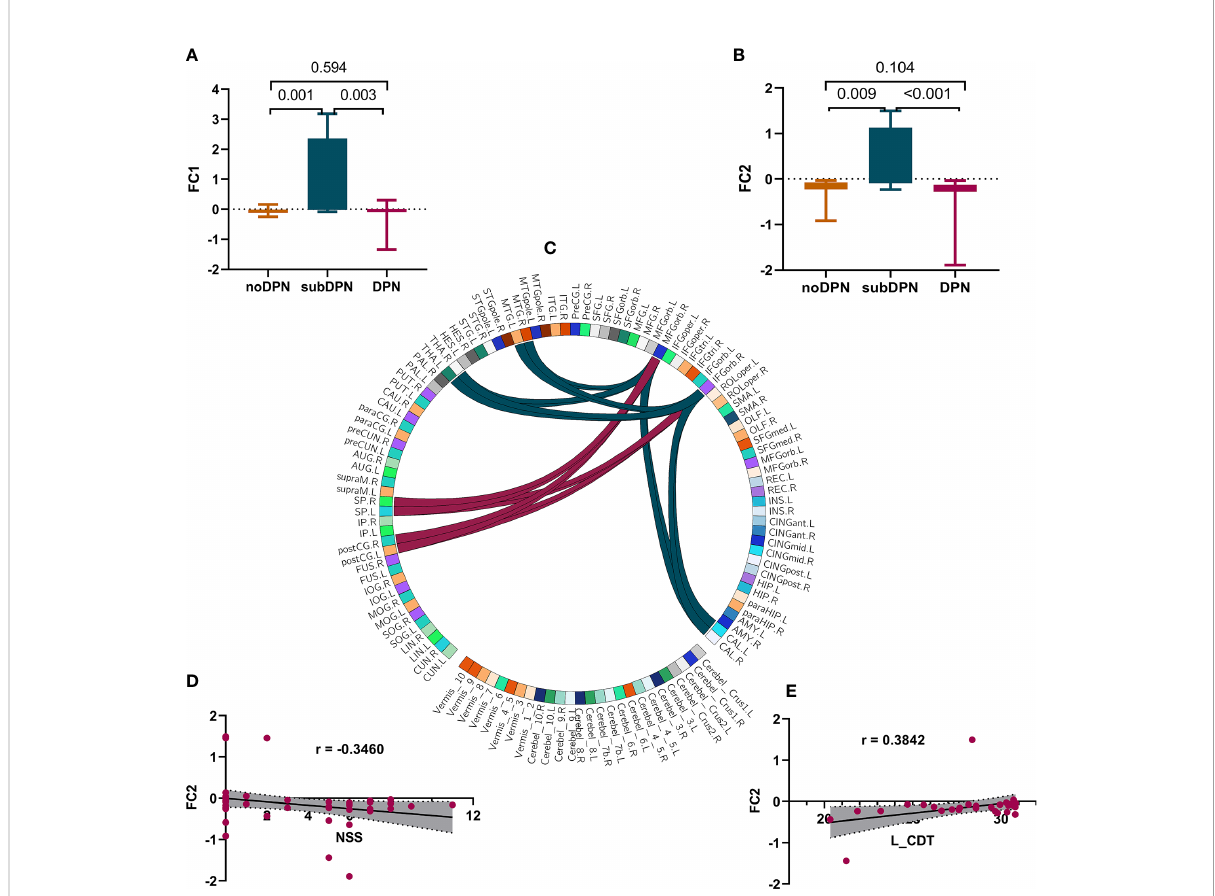
FIGURE 3 Presentations offunctional connectivity differences among groups and related correlations. (A, B) . post-hoc results of FC1 (A) and FC2 (B) . (C) a sketch diagram denoted a signi fi cant difference in functional connectivity between cerebral regions. The dark green and red link lines denote FC1 and FC2, respectively. (D, E) . correlations of FC2 with NSS (D) and left CDT (E) . FC, functional connectivity values after fi sher-Z transformation; FC1. connectivity of OFC with bilateral MTG/THA/CAL. FC2. connectivity of OFC with bilateral postCG/SP. L, left; R, right. OFC, the orbitofrontal cortex; MTG, middle temporal gyrus; THA, thalamus; CAL, calcarine gyrus; postCG, the postcentral gyrus; SP, superior parietal gyrus; NSS, the Neuropathy Symptom Score; CDT, cold detection threshold; DPN, type 2 diabetic polyneuropathy; subDPN, subclinical type 2 diabetic polyneuropathy; noDPN, type 2 diabetes without